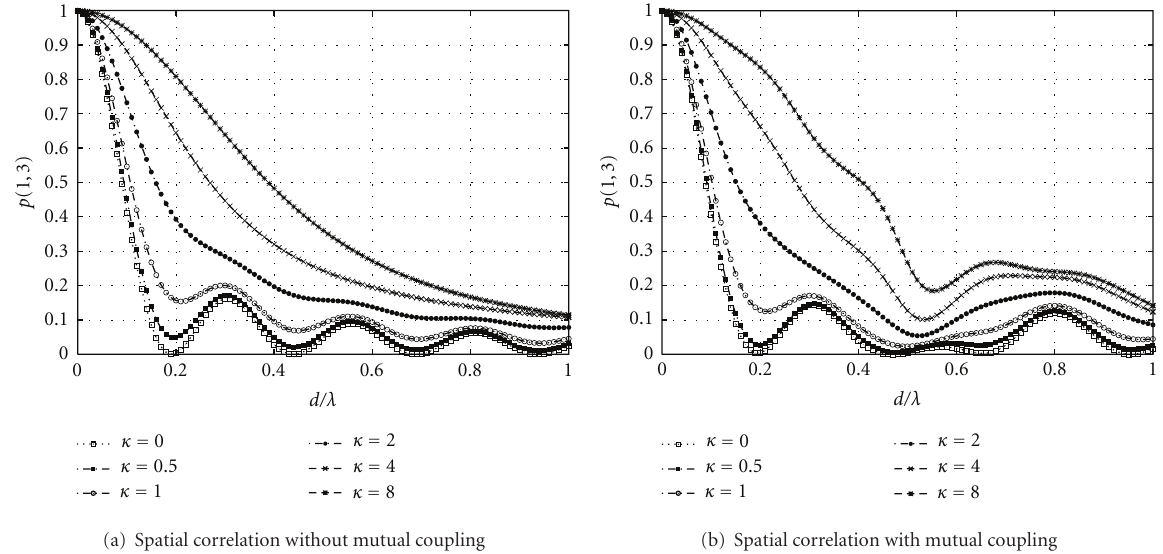
Figure 4: Spatial correlation between elements 1 and 3 for a linear array with six elements, and di ff erent values of the parameter κ , with φ p = 60 ◦ , as a function of d/λ